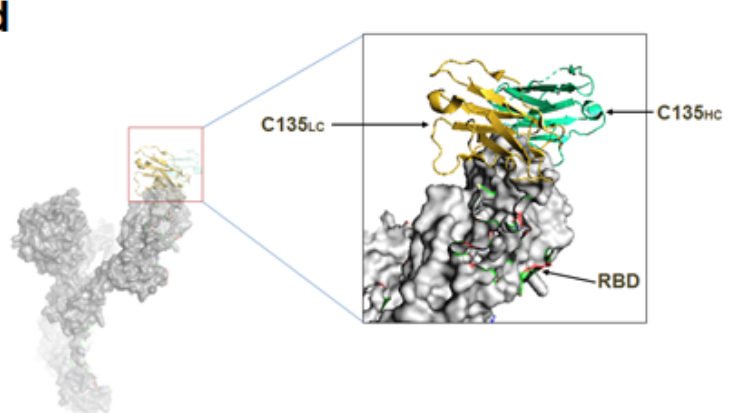
Figure 6. Different types of nAb based on structural and functional attributes. ( a ) Class I nAb (CDRH3) binds with open RBD (C102 Fab-RBD complex). ( b ) Class II nAb S309 bind with both ACE2 and RBD (309LC-ACE2 RBD complex). ( c ) Class III nAb C135 bind distinct RBD part (C135HC and S309LC with RBD). ( d ) Class IV nAb C135 bind with only up conformation of RBD (C135 HC and C135 LC with RBD). [PDB id: 6WPS, 7K8M].